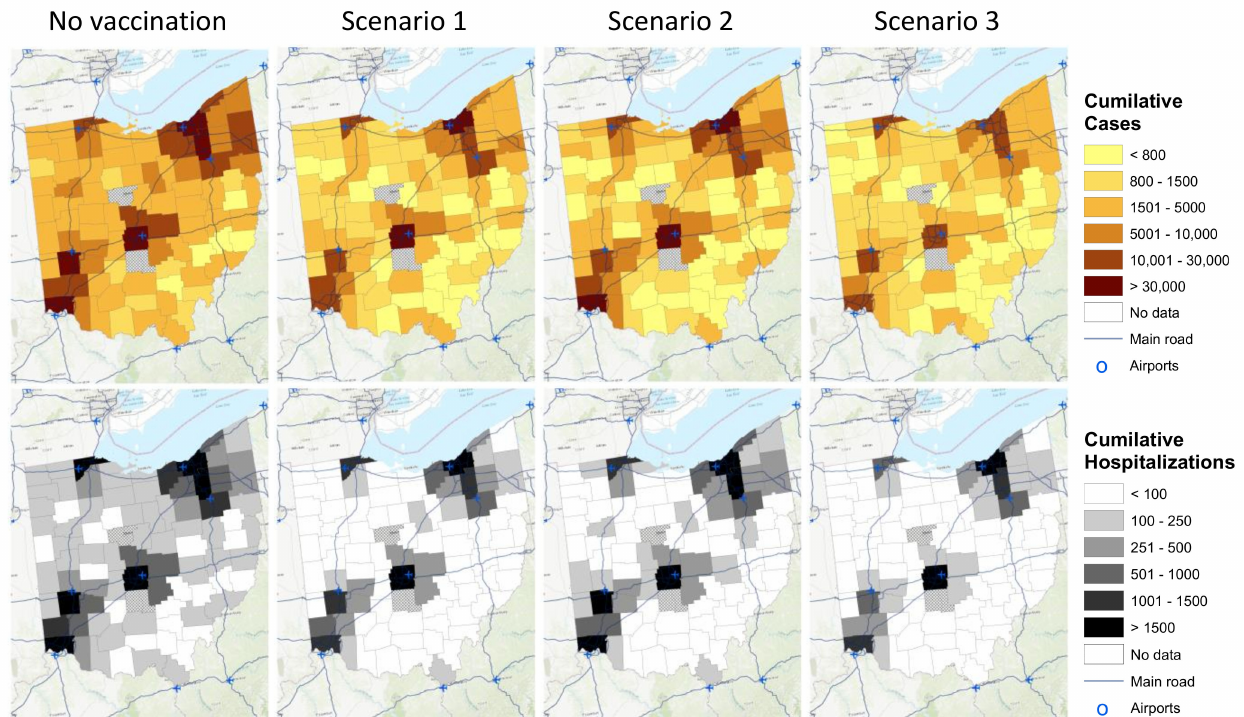
Figure 3. The adjusted spatial model estimated the spatiotemporal dynamics of the cumulative number of COVID-19 cases (maps on the top) and the cumulative number of COVID-19 hospitalizations (maps on the bottom). Maps were created using ArcGIS ® by ESRI version 10.3 (http://www.esri.com, accessed on 10 August 2021) [32]. Scenario 1, one-million vaccine doses were distributed homogeneously across Ohio’s different spatial risk areas. Scenario 2, 60% of all vaccines were administered to Group 3 and Group 4 (i.e., identified as areas with low infection intensity), while 40% of the vaccines were equally distributed across Group 1 and Group 2 (i.e., identified as areas with high infection intensity). Scenario 3, 90% were equally distributed across Group 1 and Group 2, and only 10% of all vaccines were allocated to Group 3 and Group